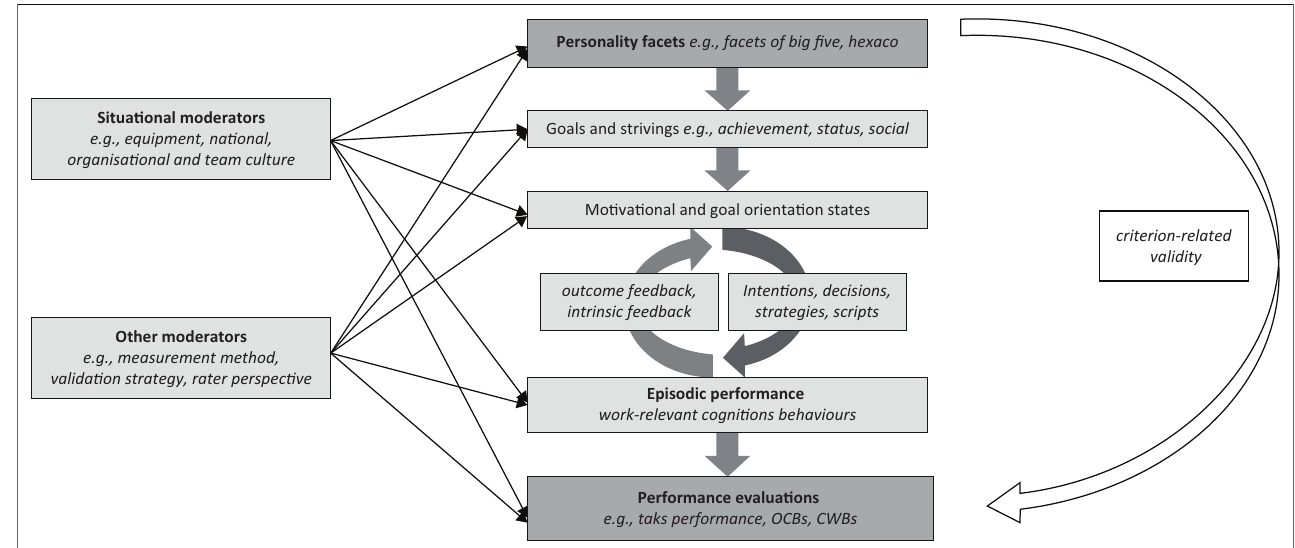
FIGURE 1: Personality-performance relationship